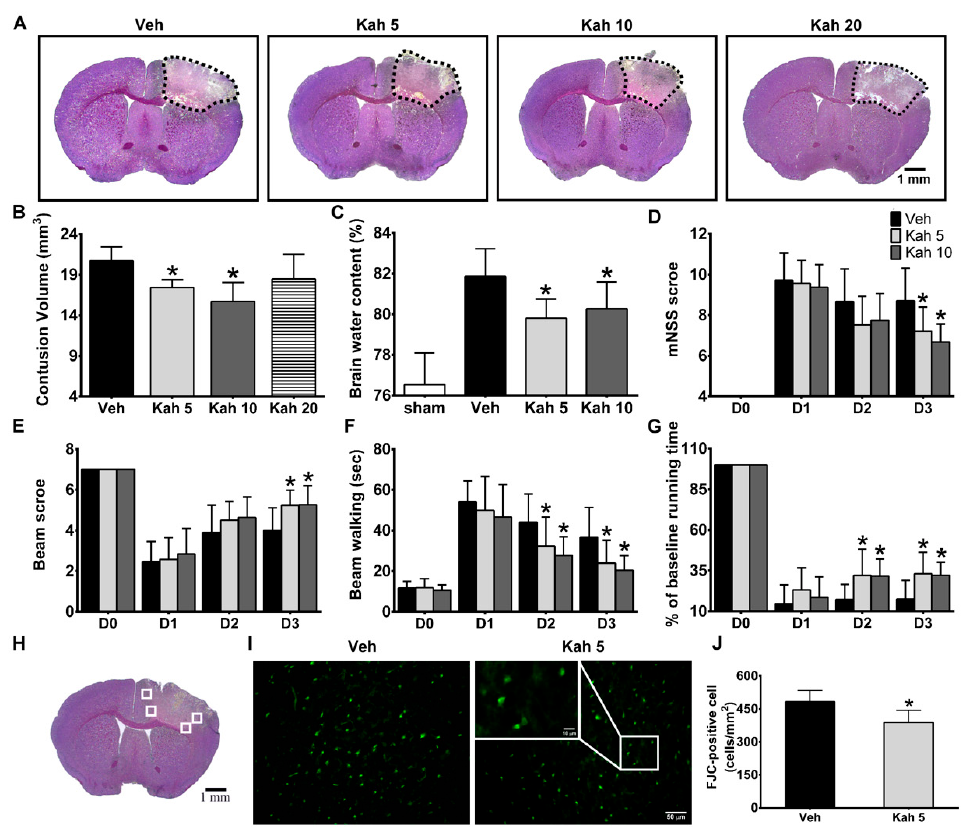
Figure 1. Kahweol treatment improved acute TBI outcomes. ( A ) Representative cresyl violet-stained brain sections of kahweol-treated TBI animals. Dotted area indicates contusion region that lacks staining in the ipsilateral cortex at day 3 post-injury. Scale bar = 1 mm. ( B ) When compared with Veh group, Kah 5- and Kah 10-treated groups significantly had smaller contusion volume. There was no significant change in brain contusion volume between Veh- and Kah 20-treated groups. n = 10 for Veh, Kah 5, and Kah 10 groups and n = 6 for Kah 20 group. * p < 0.05 versus vehicle group. ( C ) Brain water content was reduced by Kah 5 and Kah 10 treatment at day 3 post-injury. n = 11 for sham group, n = 10 for Veh and Kah 5 groups, and n = 12 for Kah 10 group. * p < 0.05 versus vehicle group. In addition, Kah 5 and Kah 10 significantly reduced ( D ) modified neurological severity score (mNSS) at day 3 post-CCI, improved ( E ) beam score on day 3, reduced ( F ) the beam walk latencies at days 2 and 3, and improved ( G ) the rotarod performance at days 2–3 post-injury. n = 21 for Veh and Kah 5 groups and n = 19 for Kah 10 group. * p < 0.05 versus vehicle group. ( H ) Representative cresyl violet-stained TBI brain section shows areas (white box) selected for Fluoro-Jade C (FJC)-positive cell counting. Scale bar = 1 mm. ( I ) Representative FJC-stained sections of a vehicle-treated and Kah 5-treated animal at three days post-injury. Inset shows FJC-positive cells at a higher magnification. Scale bar = 50 µm in the full image and 10 µm in the inset. ( J ) Quantification shows that Kah 5 significantly reduced the number of degenerating neurons at three days post-injury. n = 5 for Veh group and n = 6 for Kah 5 and Kah 10 groups. * p < 0.05 versus the Veh group. Throughout, data are the mean ± SD. Veh, vehicle; Kah 5, kahweol 5 mg/kg; Kah 10, kahweol 10 mg/kg; Kah 20, kahweol 20 mg/kg.